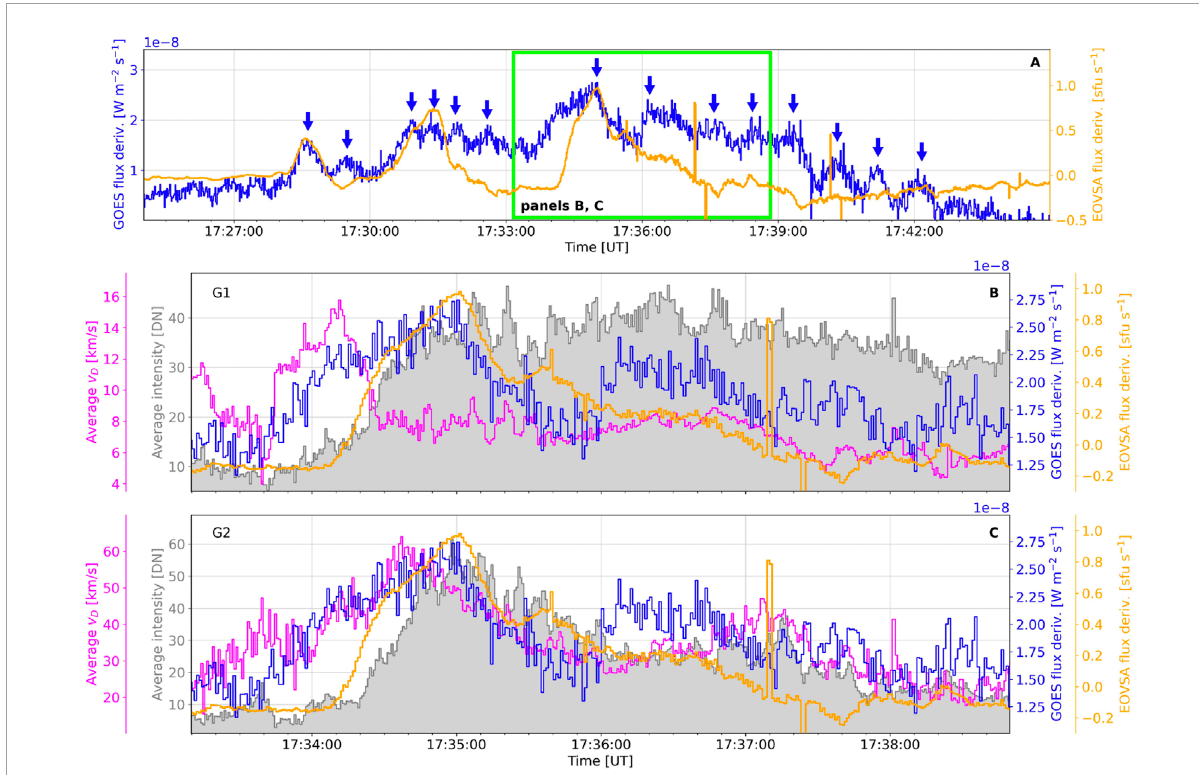
FIGURE 9 Panel (A) demonstrates quasi-periodic pulsations (QPPs, blue arrows) observed during the impulsive and peak phases of the flare. The blue curve is the time derivative of the GOES SXR flux in its 1–8Å channel, while the orange curve corresponds to the microwave radio emission averaged in the range of 2.4–5GHz observed by EOVSA. Panels (B) and (C) compare a section of these lightcurves [lime box in panel (A) ] with properties of fits of two Gaussians fitting spectra of the Si IV 1402.77Å line. The grey filled curve represents time variations of the observed intensity, while the magenta curve corresponds to the Doppler velocity v D averaged in the ribbon. The GOES and EOVSA data plotted in this figure were produced using data smoothed with a 15 s